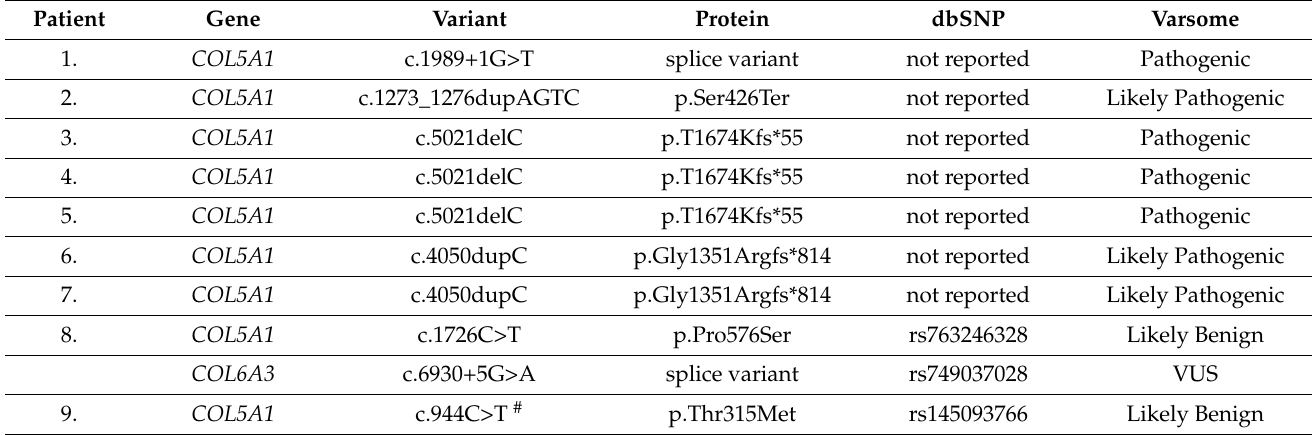
Table 2. Variants in COL5A1 and COL5A2 genes detected in the investigated